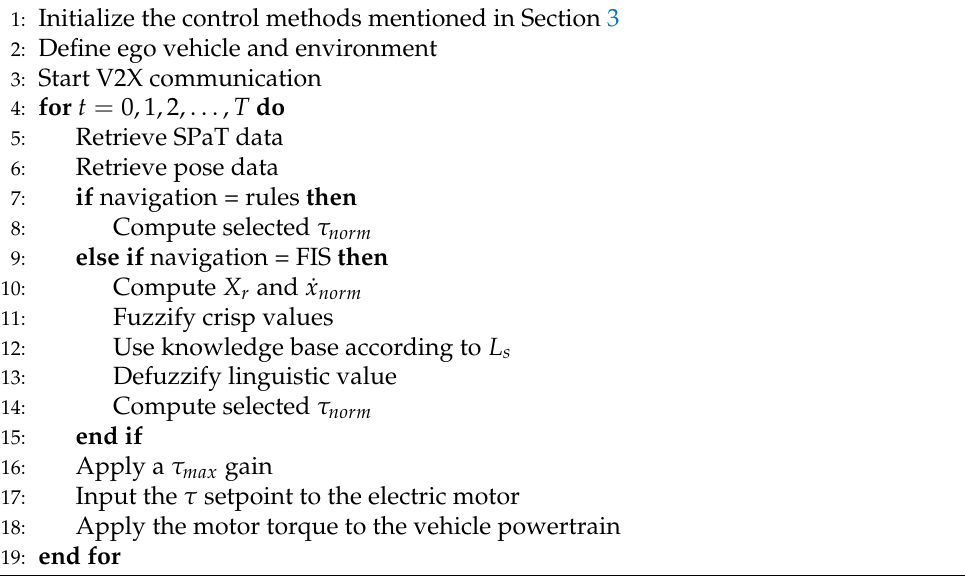
Algorithm 5 Integrated data acquisition and control algorithm for the connected electric vehicle